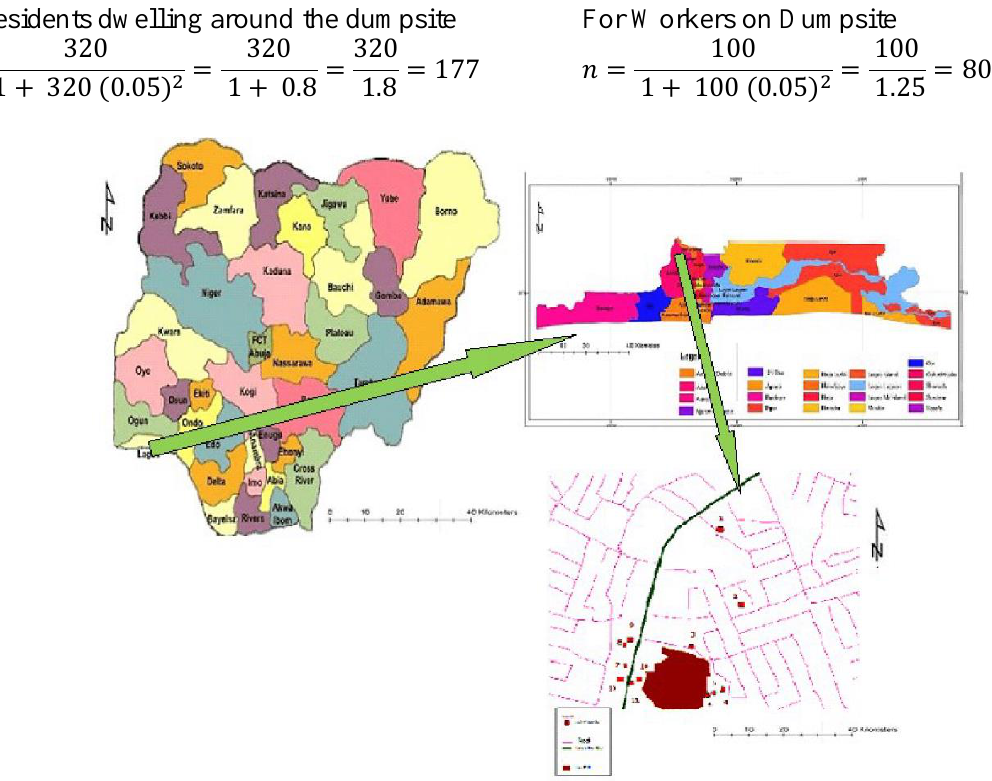
Fig. 1. Map of sites where questionnaires were administered (extracted from Alimosho Local Government, Lagos, Nigeria; location of Solous